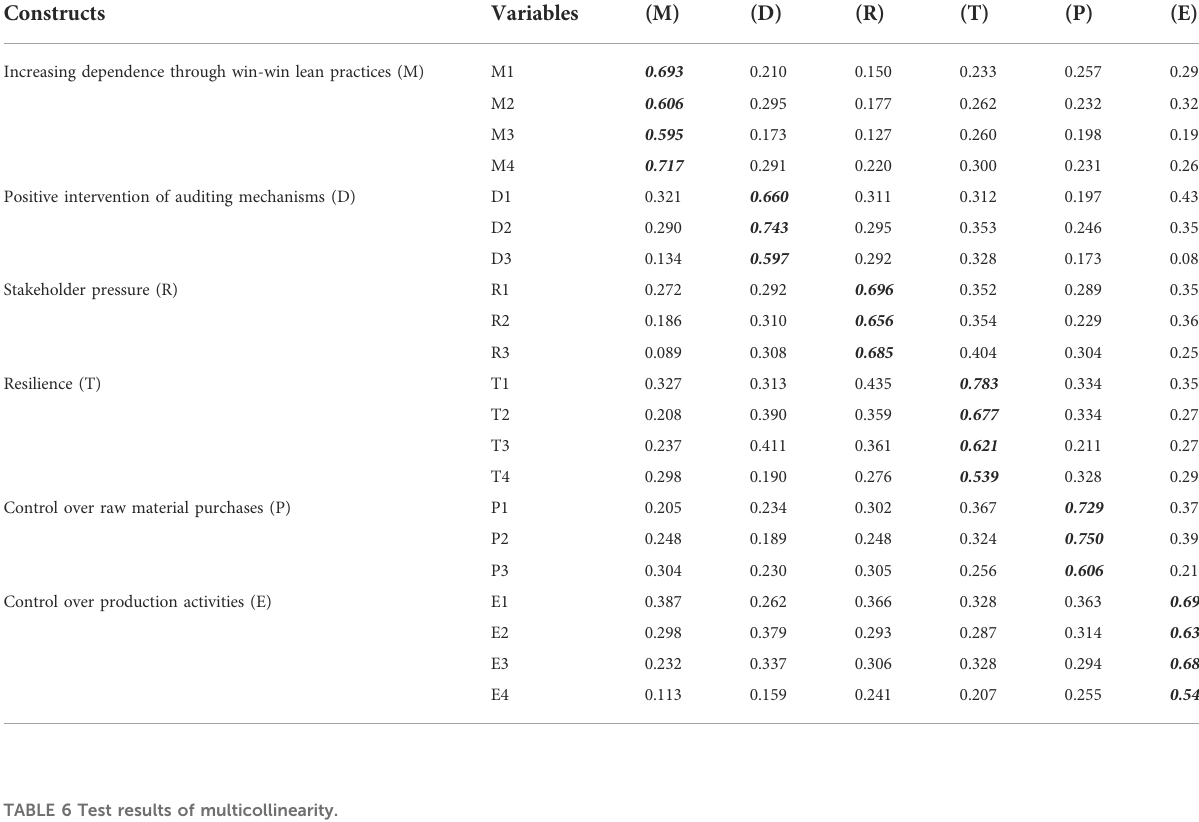
TABLE 5 Analysis results of Cross Loadings.